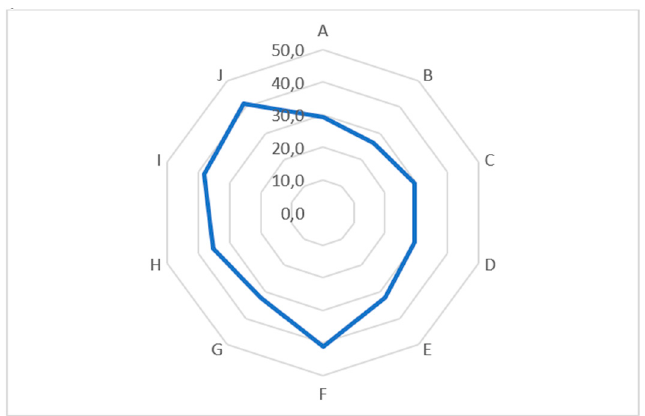
Figure 8. The number of organizations that assessed the scope of support as good and very good